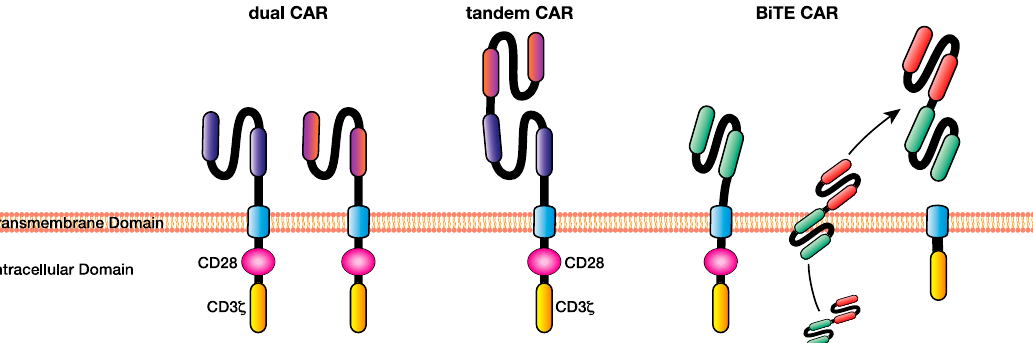
Figure 3. Multi-targeting chimeric antigen receptor (CAR) T cell approaches facilitate the elimination of heterogeneous cancers through the recognition of multiple antigens, overcoming some of the issues of single-targeting CAR T cell immunotherapy such as antigen escape. Examples of multi-antigen targeting CAR T-cell approaches include dual CARs, in which T cells express CARs specific for multiple antigens, tandem CARs, where two single-chain variable fragments (scFv’s) specific for different antigens are included in the ecto-domain separated by a Gly-Ser linker, and BiTE CARs, which are CAR T cells capable of secreting a BiTE targeting a different antigen to the CAR at the tumour site. BiTE: bi-specific T cell engager.